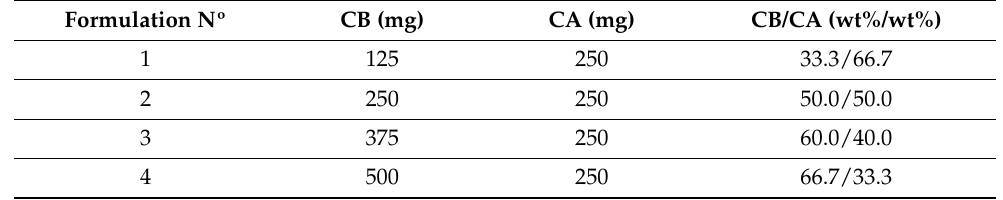
Table 1. CB/CA proportions at the different prepared